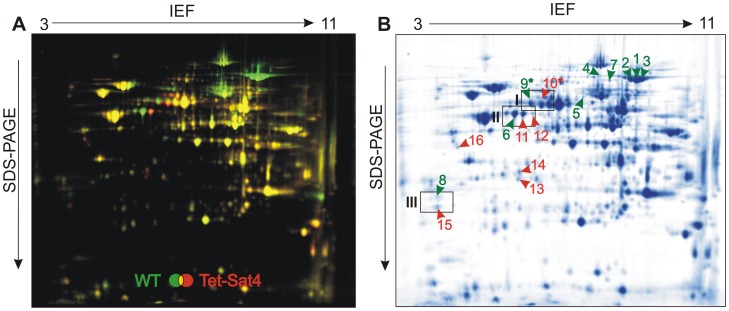
2D-DIGE of mt proteins from wild type and Tet-Sat4 strain.Mitochondria were isolated and purified by sucrose gradient centrifugation. Proteins were labeled with Cy3 (wild type (WT), shown in green) or Cy5 (Tet-Sat4, shown in red) and separated by a non-linear isoelectric focussing (IEF; pH 3–11) followed by 12% SDS-PAGE. An overlay of the channels detected by a Typhoon Trio fluorescence scanner is shown in (A). Subsequently, the gel was stained with colloidal Coomassie (B). Labeled spots were excised and analyzed by mass spectrometry (results listed in table 1). Protein spots, which showed lower abundance in the Tet-Sat4 strain, are marked by green numbers (1–9), whereas higher abundant proteins are highlighted in red (10–16). Framed gel regions (I–III) are shown in detail in fig. 4.